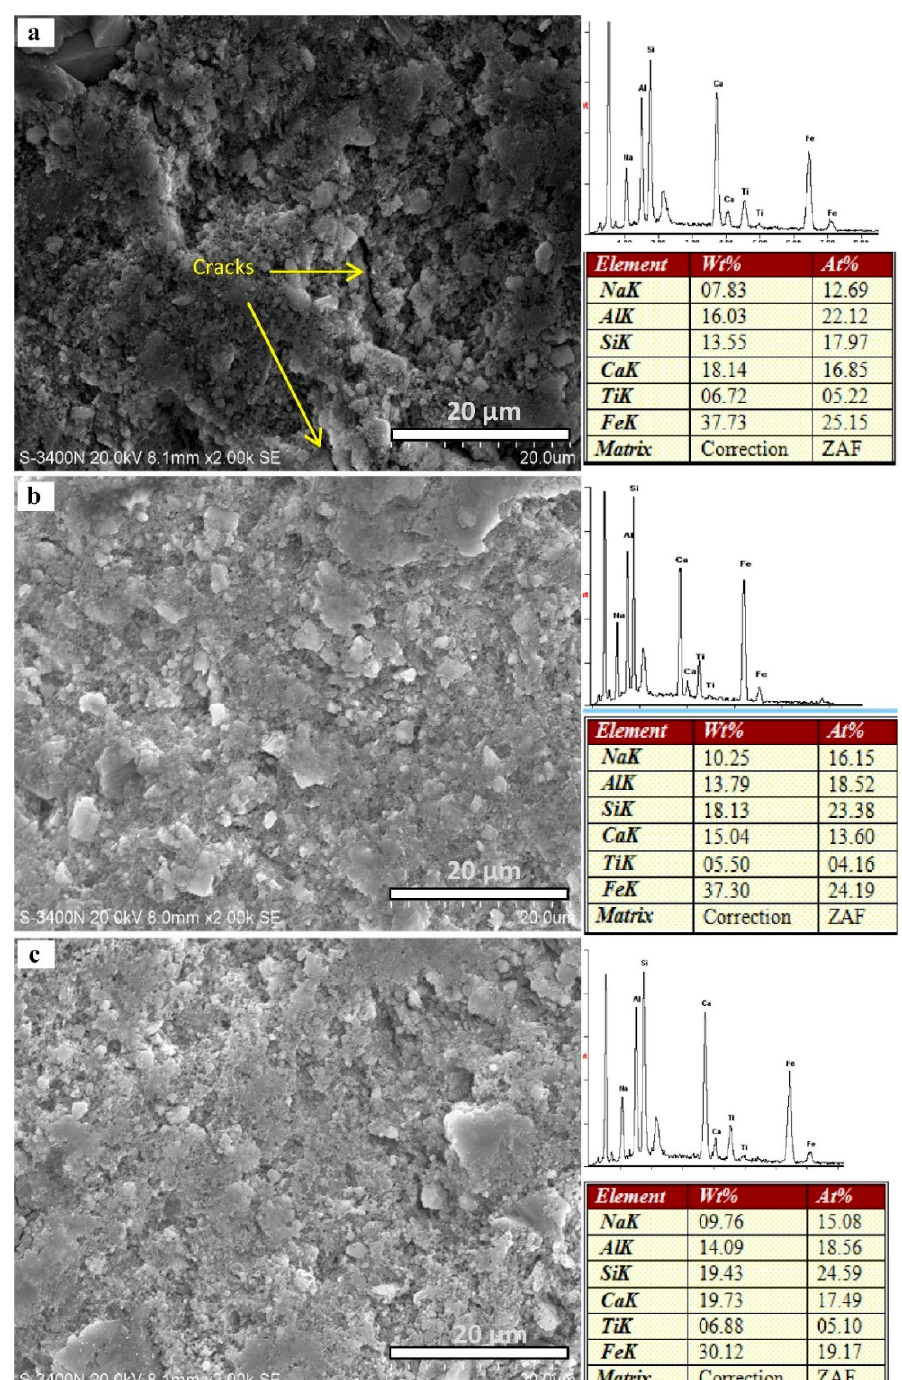
Figure 5. EDS analysis at ( a ) 60 °C ( b ) 300 °C and ( c ) 800